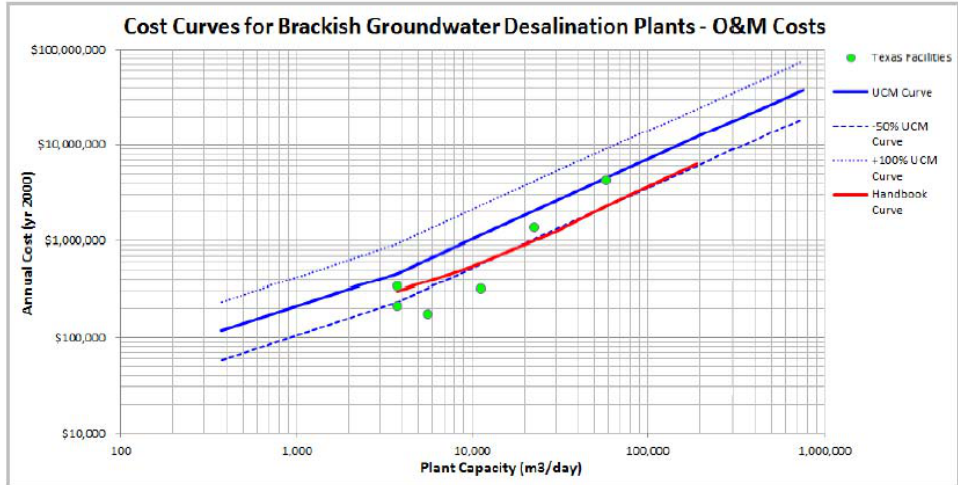
Figure 8. Comparison of the OPEX costs for nine BWRO plants in Texas to the cost curves developed by the Unified Costing Model [53] and the Desalting Handbook for Planners [30]. Note the cost increase may have occurred at these utilities since the data were compiled for use in the model until current conditions.